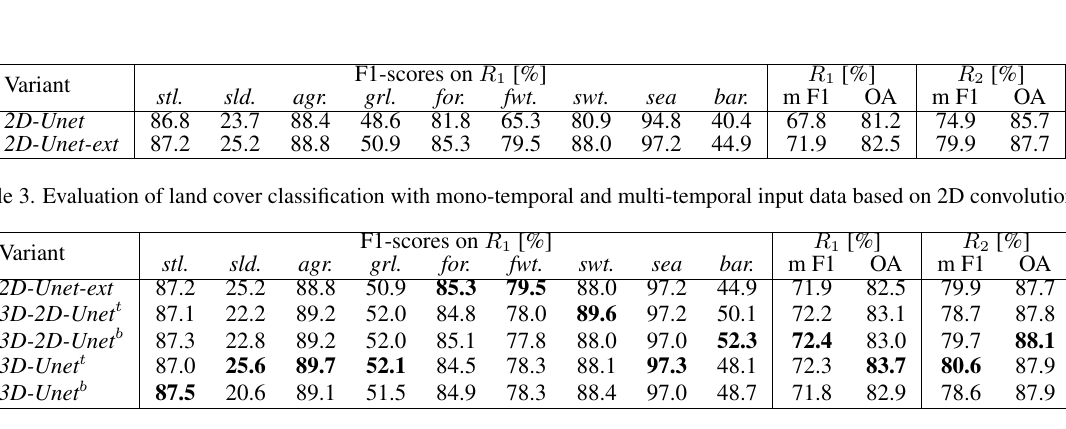
Table 4. Evaluation of land cover classification with multi-temporal input data based on different network architectures (cf. table 2). obtain an input for the CNN with equal size for every